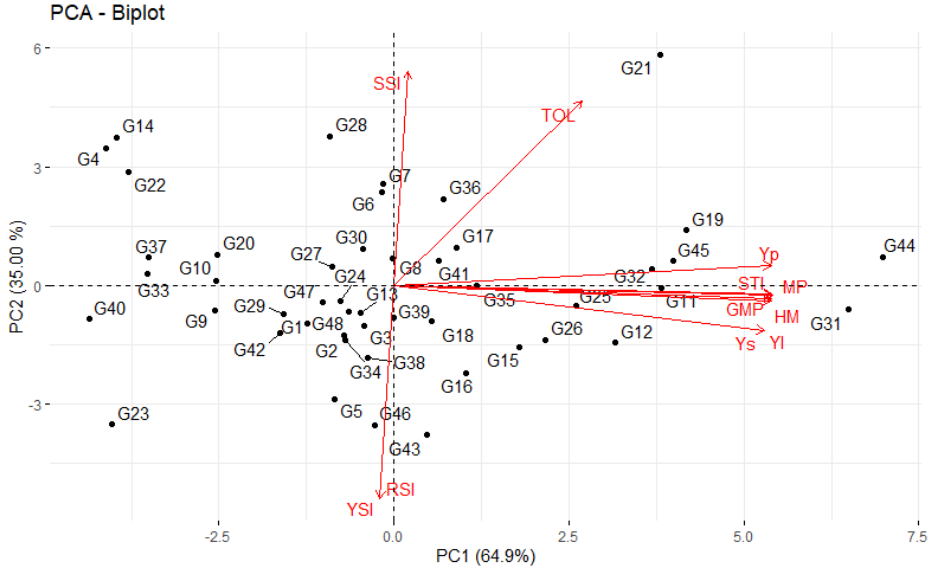
Figure 4. PCA biplot for the grain protein content based on the first (PC1) and the second (PC2) principal components for the wheat cultivars (G1–G48) and different stress tolerance